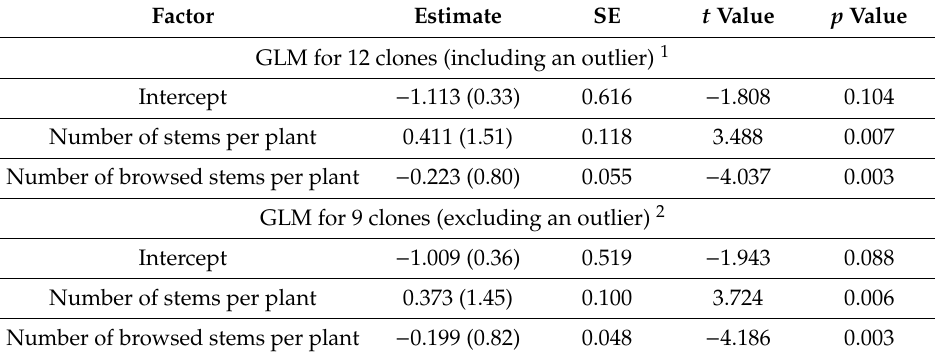
Table 1. A summary of the generalized linear models (GLMs) of estimated willow yield under deer browsing conditions for each clone. A gamma distribution with a log-link function was used for the models. One model includes all 12 clones studied, and another model comprised 11 clones, excluding an outlier. The models incorporate the number of stems and browsed stems per plant as explanatory variables. The numbers in parentheses in the “Estimate” column represent the exponential value of the estimate. SE is the standard